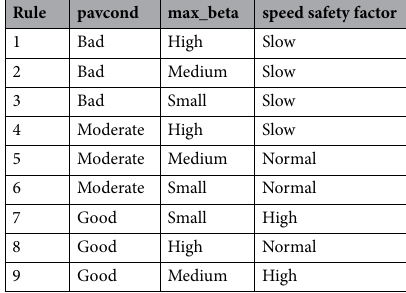
Table 3. Fuzzy rules.